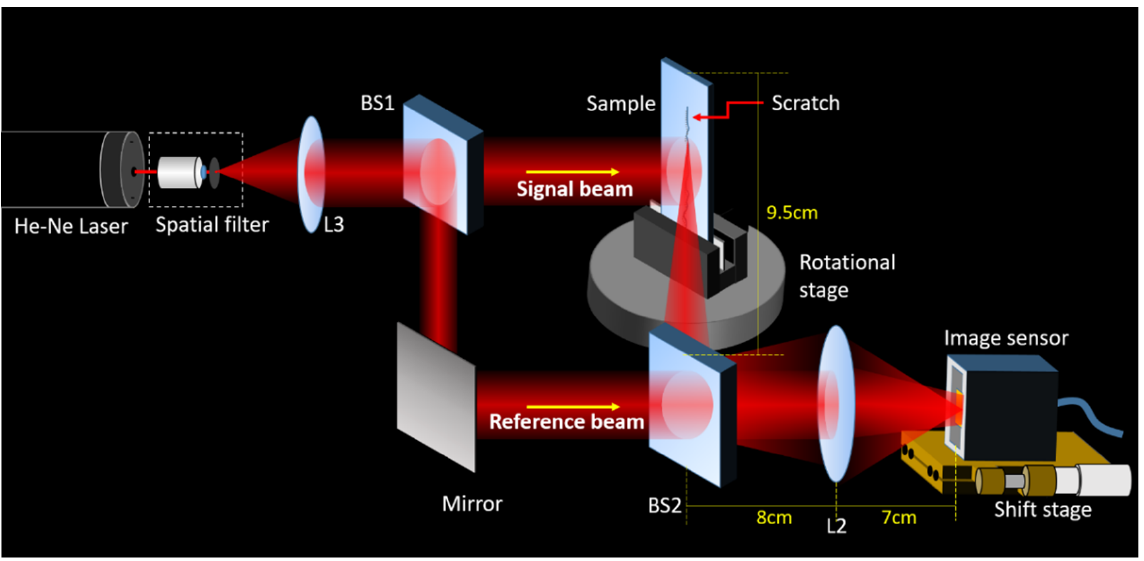
Figure 5. Schematic diagram of the DHD setup, where BS means beam splitter, and L means lens. Figure 6 shows the target images taken by the DHD system. We found the scattering noise still mixed with the scratch signal. Thus, the method worked independently with the sample’s thickness. The first row (a–d) shows the reconstructed pictures with white paint on the back surfaces of the glass. The second row (e–h) shows the reconstructed pictures with gray paint. The third row (i–l) shows the reconstructed pictures with white paint. Images (a), (e), and (i) in the first column show the reconstructed pictures with the interference fringe suffering 3 mm defocus; (b), (f), and (j) in the second column show the reconstructed pictures with the interference fringe suffering 6 mm defocus; (c), (g), and (k) in the third column show the reconstructed pictures with the interference fringe suf- fering 9 mm defocus; and (d), (h), and (l) in the fourth column show the reconstructed pictures with the interference fringe suffering 12 mm defocus. The images became clearer when the image was taken under defocus condition. Whether it was in-focus or defocused up to 3 mm, the reconstructed scratch after digital focusing could always be recognized. It thus shows a large defocusing tolerance in the image capture process.